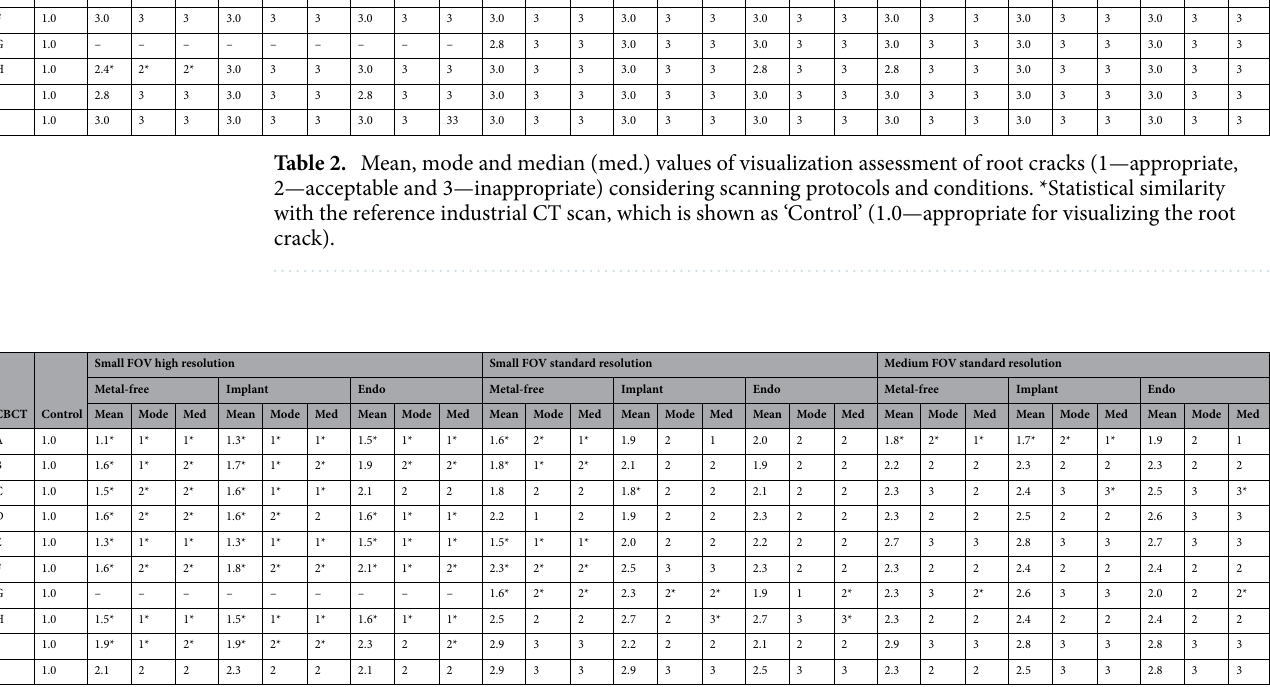
Table 3. Mean, mode and median (med.) values of visualization assessment of fine endodontic anatomical structures (1—appropriate, 2—acceptable and 3—inappropriate) considering scanning protocols and conditions. *Statistical similarity with the reference industrial CT scan, which is shown as ‘Control’ (1.0— appropriate for visualizing the anatomical